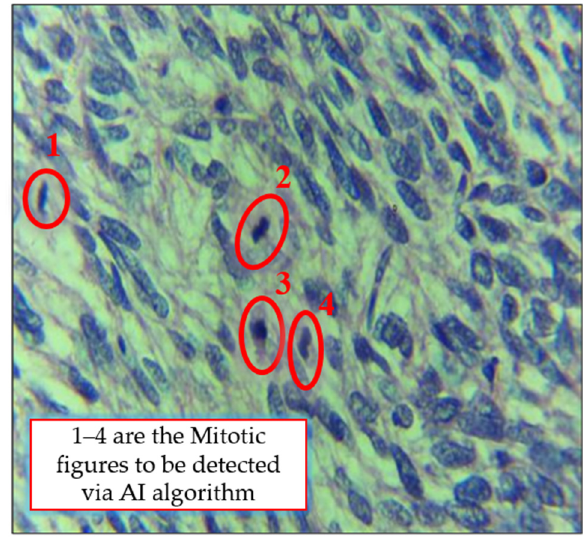
Figure 1. The microscopic image of a leiomyosarcoma (LMS) case with red highlighted areas showing the mitosis region.